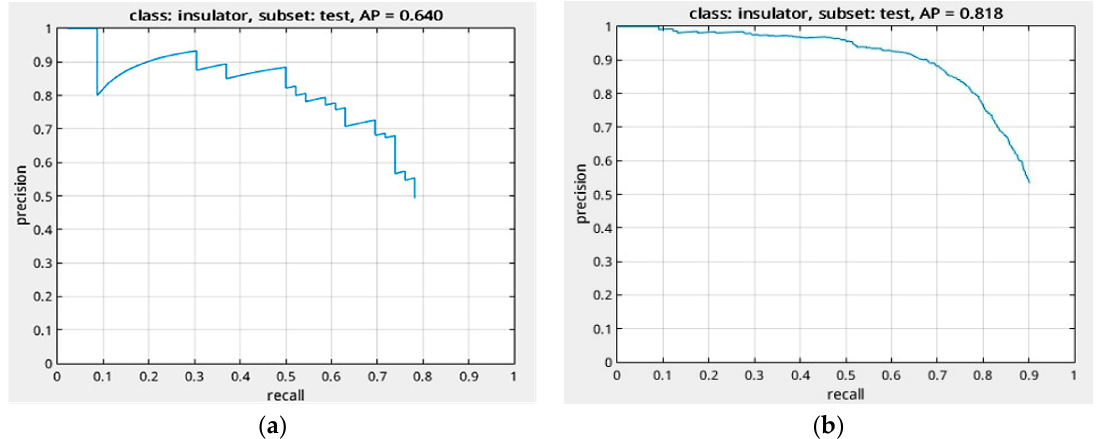
Figure 14. Precision recall (PR) curve and average precision (AP) value of the faster R-CNN model under VGG-16 Net. ( a ) Before improvement; ( b ) after improvement.